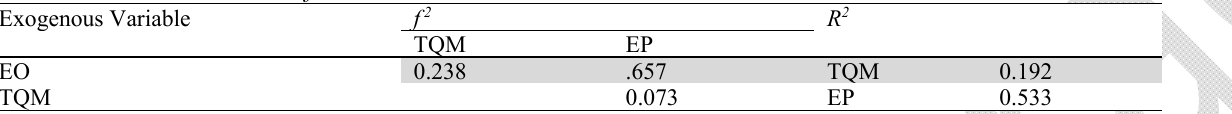
Values of R 2 and effect size f 2 Exogenous